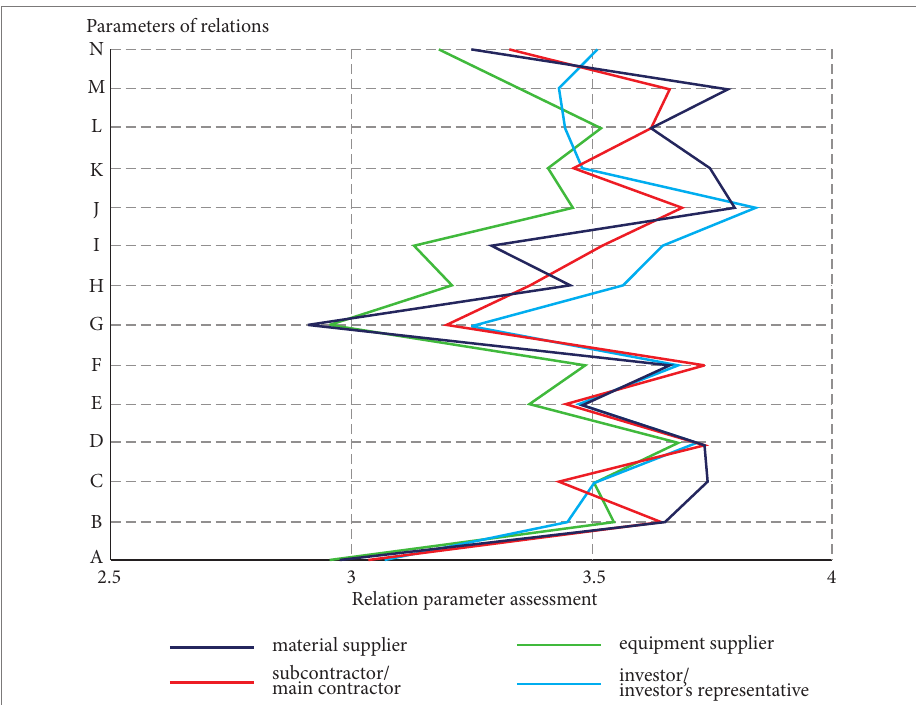
Fig. 3. The assessment profiles of the parameters of relations between Slovak construction enterprises and four